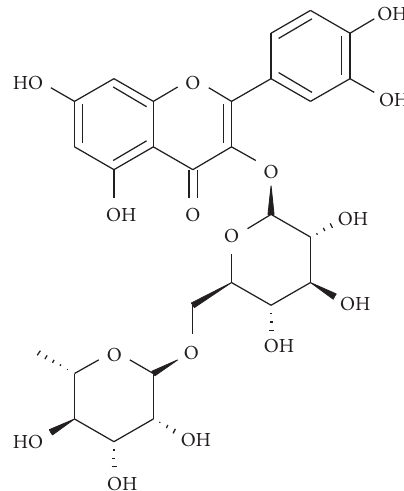
Figure 4: Chemical structure of